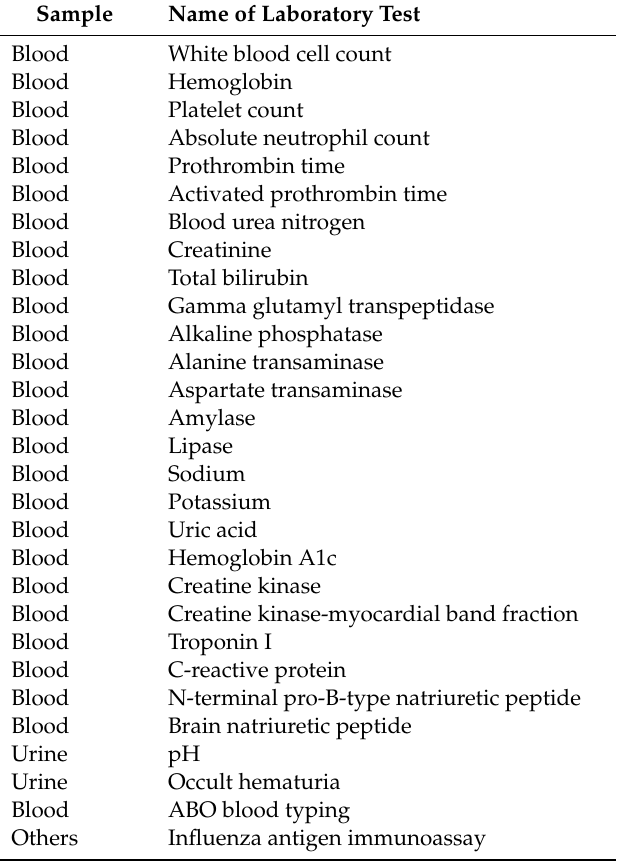
Table 2. Extraction and standardization of the most frequent laboratory